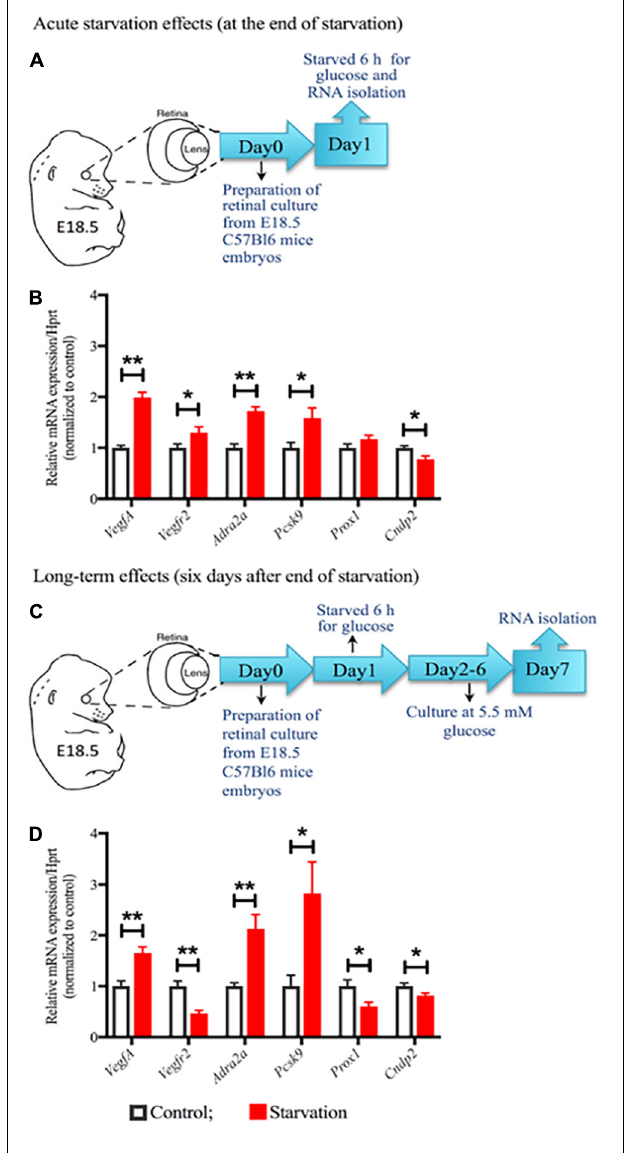
FIGURE 1 | The impact of exposure to starvation for glucose on gene expression in embryonic retinal cells. (A,C) Schematic overview of the established and validated in vitro model of embryonic retinal cells exposed to glucose starvation to mimic the perinatal exposure to famine. Dissociated retinal cell cultures were prepared from E18.5 mouse embryos and plated on dishes coated with poly- L -lysine (day 0; as described in Supplementary Methods ). The culture was starved for glucose for 6 h on day 1. RNA was isolated after the end of starvation on day 1 (A) or day 7 (C) . (B,D) Relative mRNA levels on day 1 (B) and day 7 (D) , determined by RT–qPCR ( n = 5–6). Untreated cells were used as controls. ** p < 0.01, * p < 0.05 (two-tailed paired Student’s t -test). All values are means +